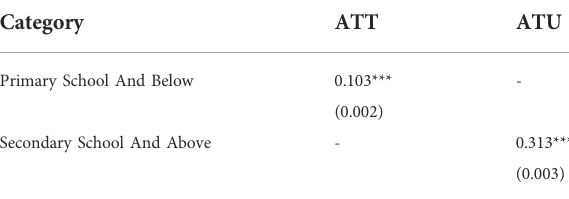
TABLE 5 The average treatment effect of different educated farmers using the internet on agricultural GPE.